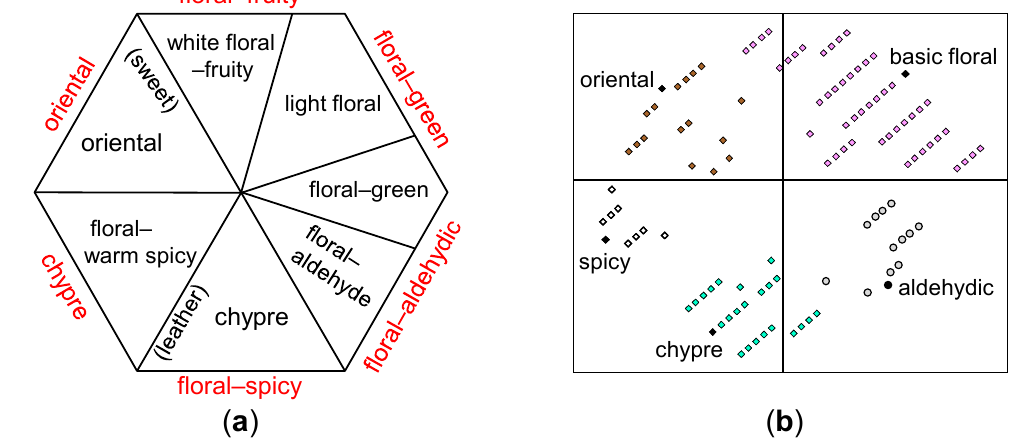
Figure 3. ( a ) Modified Hexagon of Fragrance Families. Categories in the original representation (indicated in red outside the polygon) were reorganized according to Figure 2; ( b ) Givaudan Analogies of feminine fragrances [11] (p. 276), which was properly rotated to achieve the best match with Figure 2. The fragrance most representative of each class is indicated as a black point.